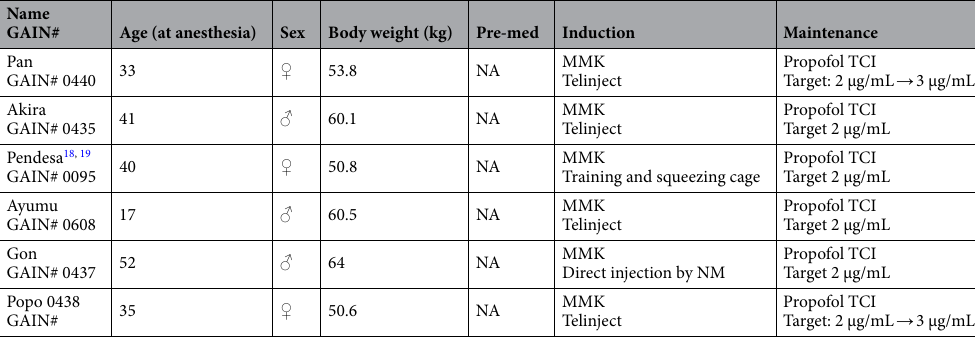
Table 2. Attempt of human propofol TCI in chimpanzees (2016–2018). MMK: Medetomidine 0.012 mg/ kg+Midazolam 0.12 mg/kg +Ketamine 3.5